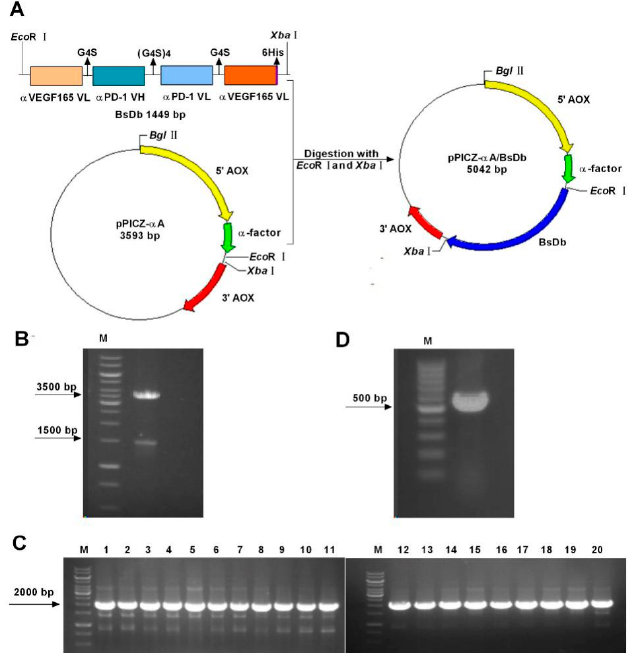
Figure 1. Construction and transformation of the pPICZ- α A/BsDb expression plasmid. ( A ) Schematic diagram of the pPICZ- α A/BsDb expression plasmid generation. The gene fragment of BsDb containing